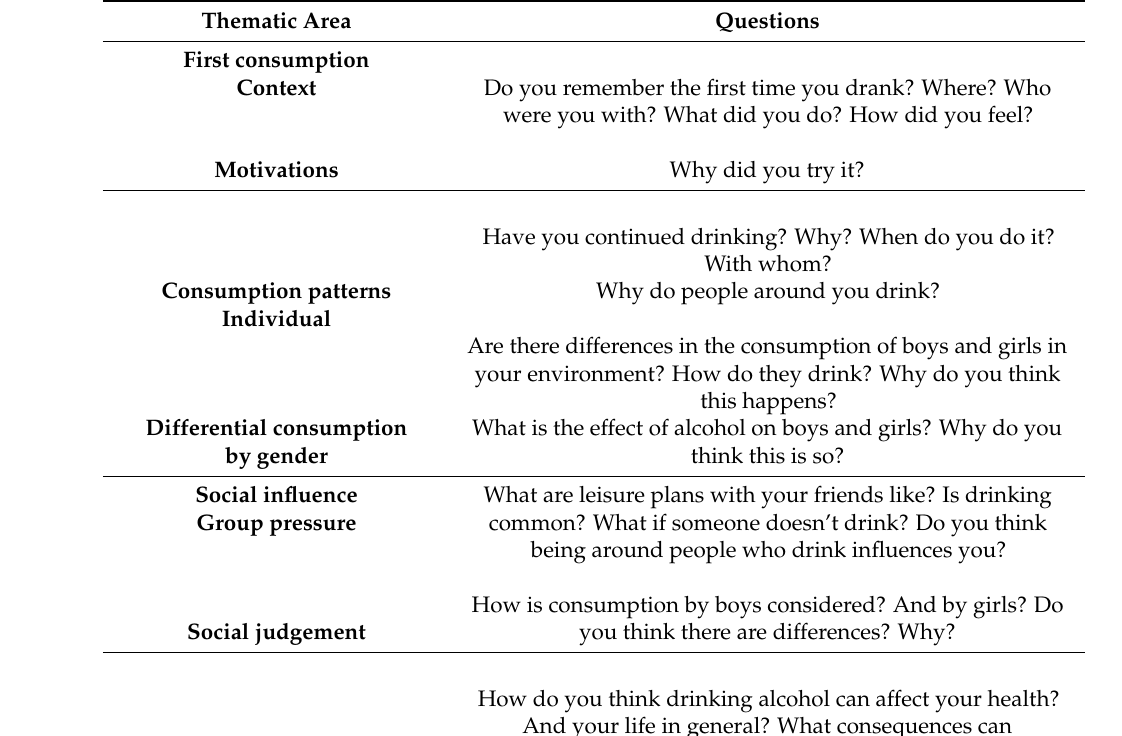
Table 2. Interview topic guide for key